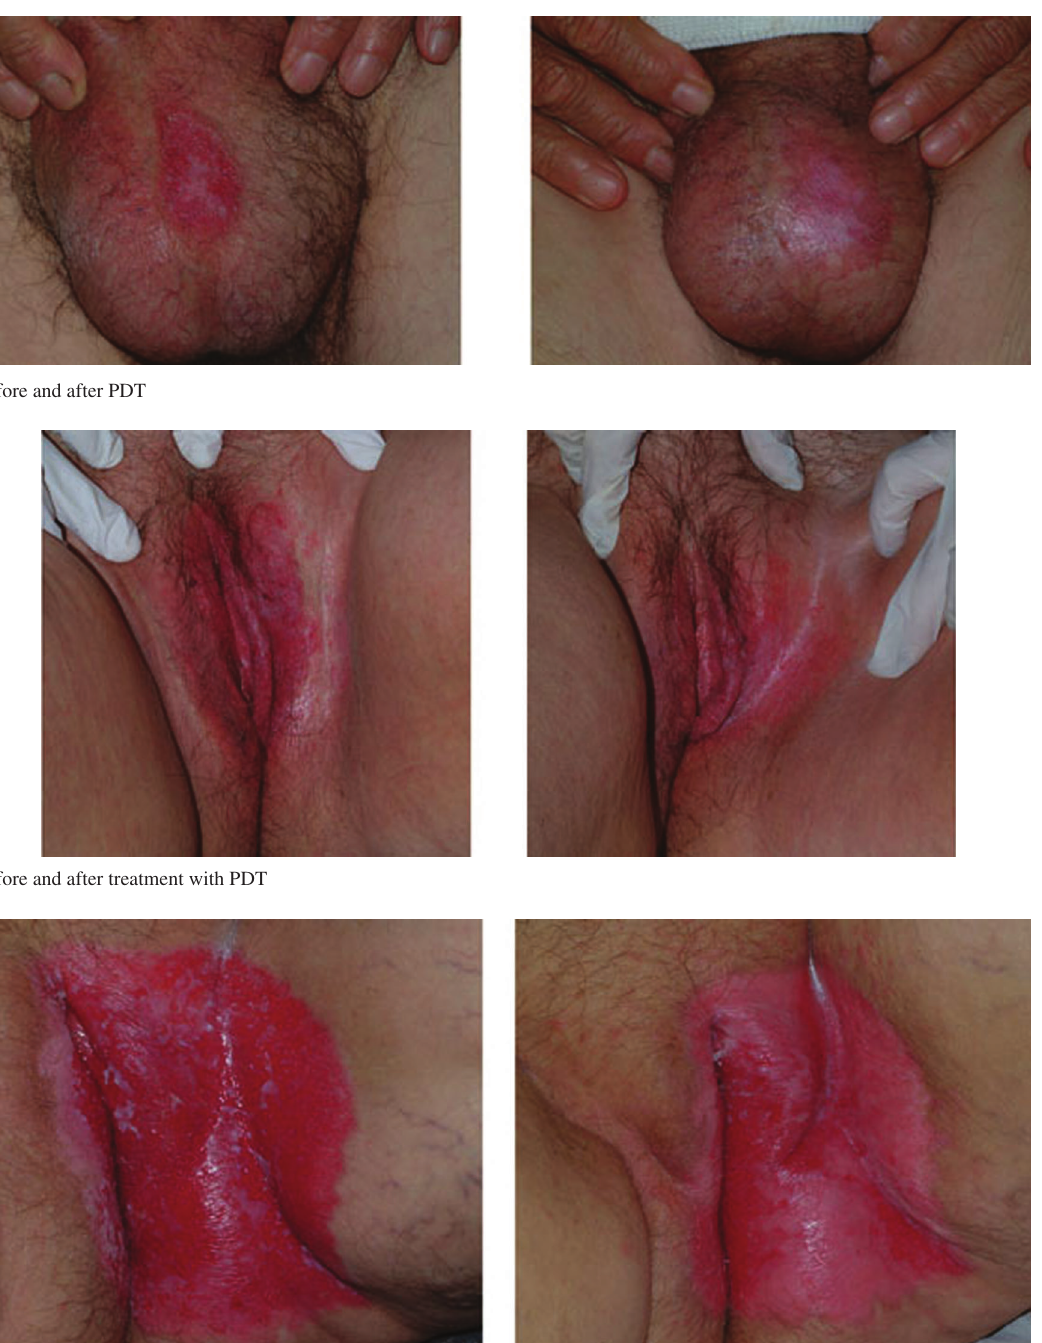
Figure 5 - Before and after treatment with